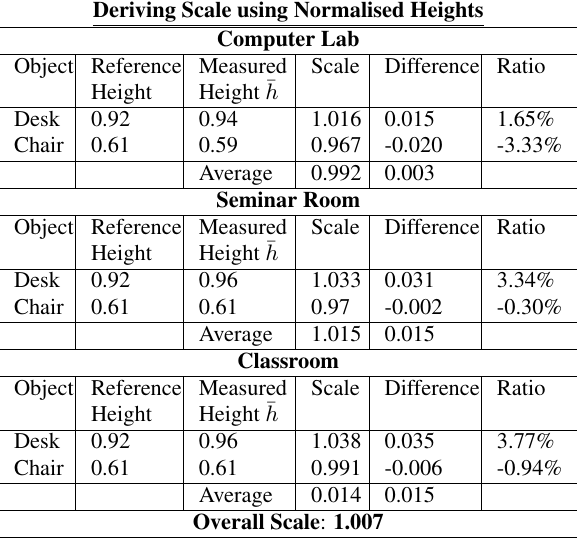
Table 4: Comparison of measured and reference heights using normalised values for identified objects within each scene.